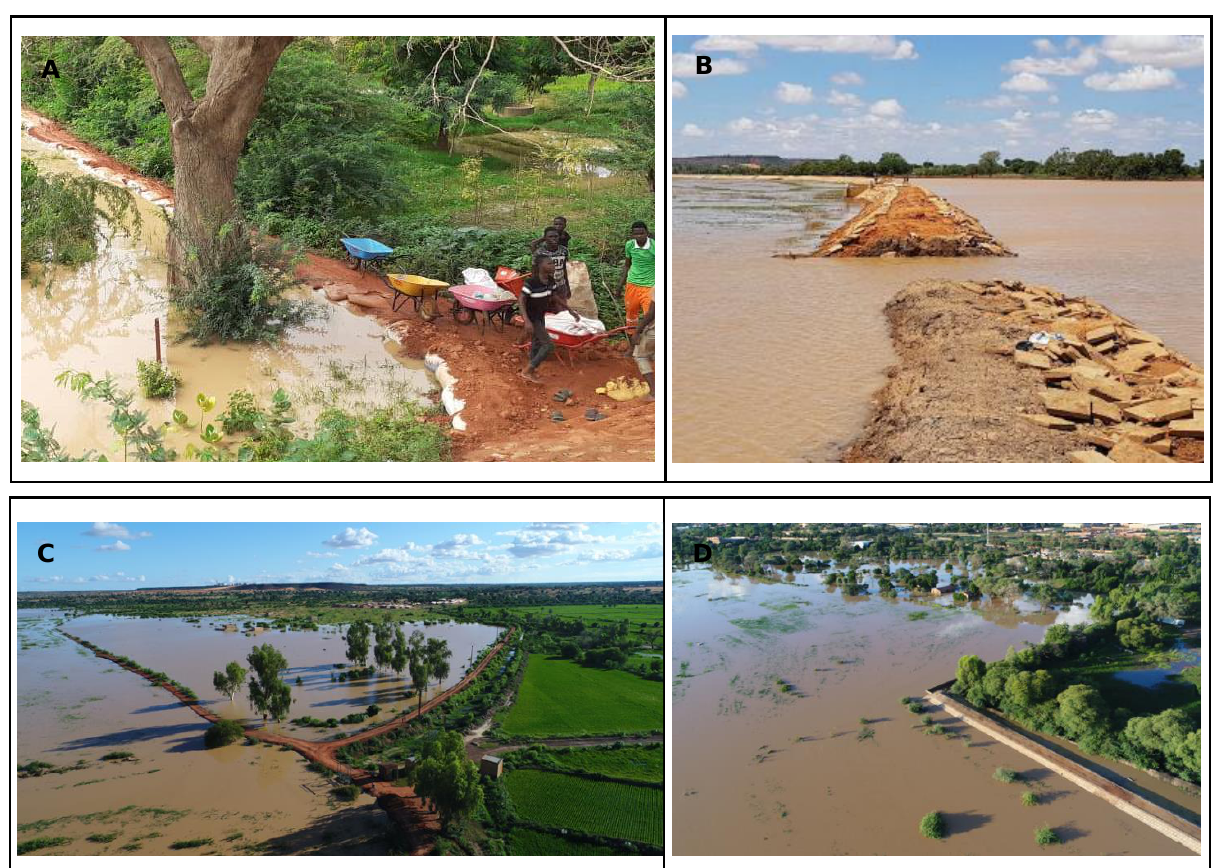
Figure 7. The Niamey levees during the 2019 and 2020 flood events: ( A ) (top-left) the bridges levee (sector B) raise with sandbags on 18/8/20 (h = 651 cm), ( B )(top-right) the levee break in Lamordé (Sector A) on 6/9/20 (h = 679 cm), ( C )(bottom- left) aerial view of Kirkissoie levee on 30/8/19 (h = 619 cm), ( D )(bottom-right) aerial view of Saga levee on 30/8/19 (h = 619 cm).